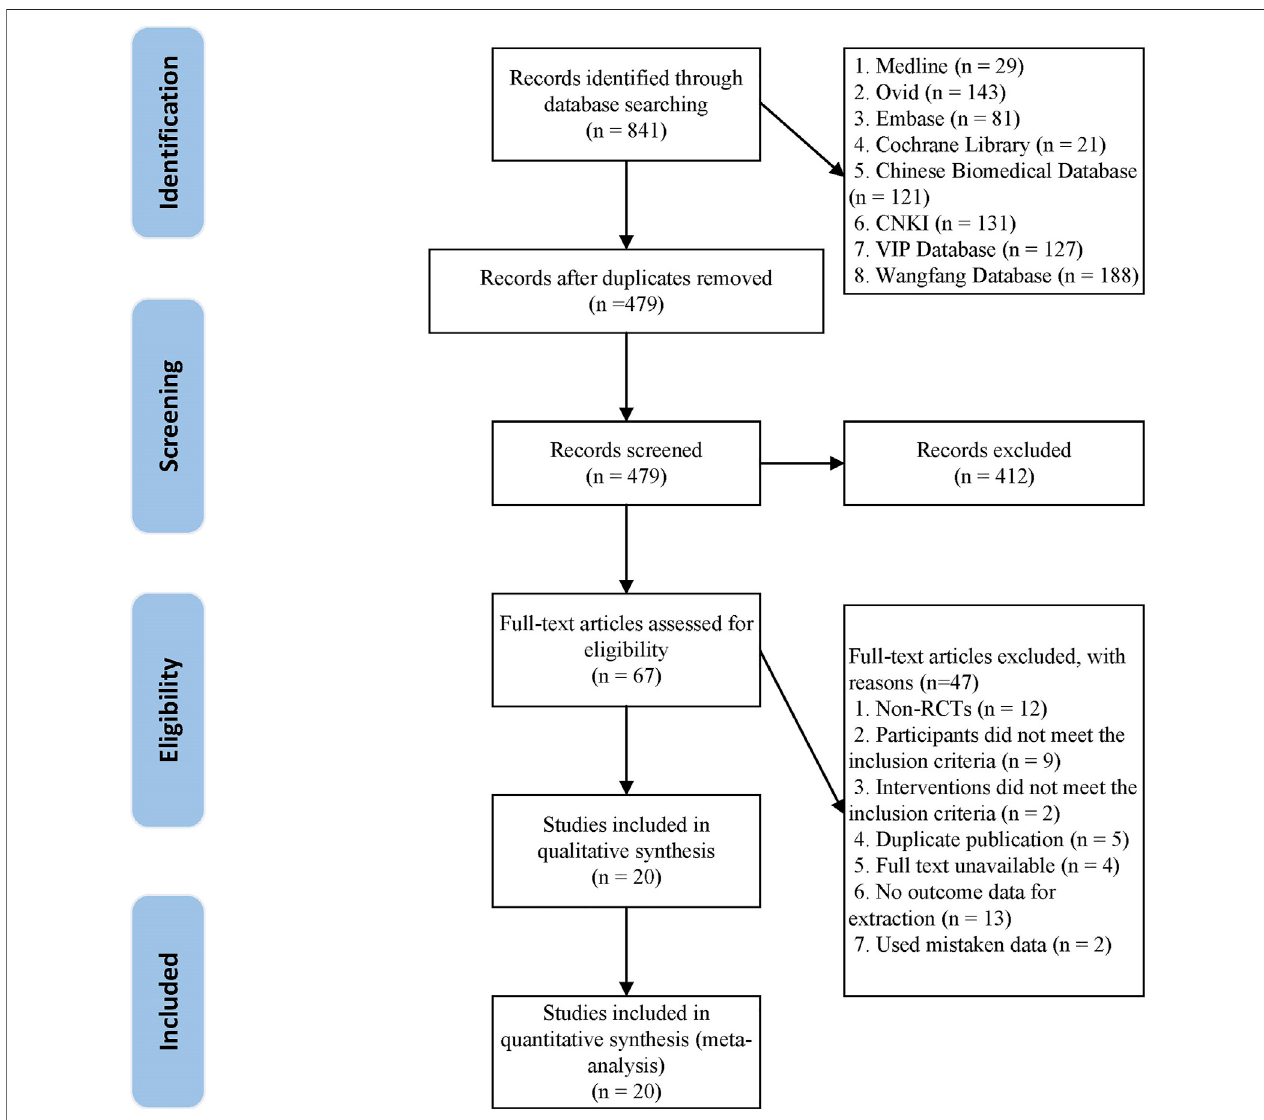
FIGURE 1 | The fl ow chart of the study selection